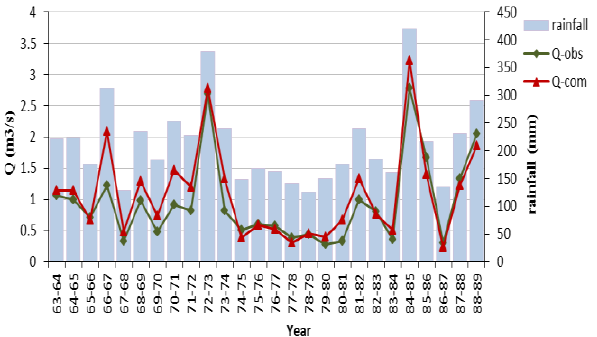
Figure 10. The result of computed and observed outlet runoff